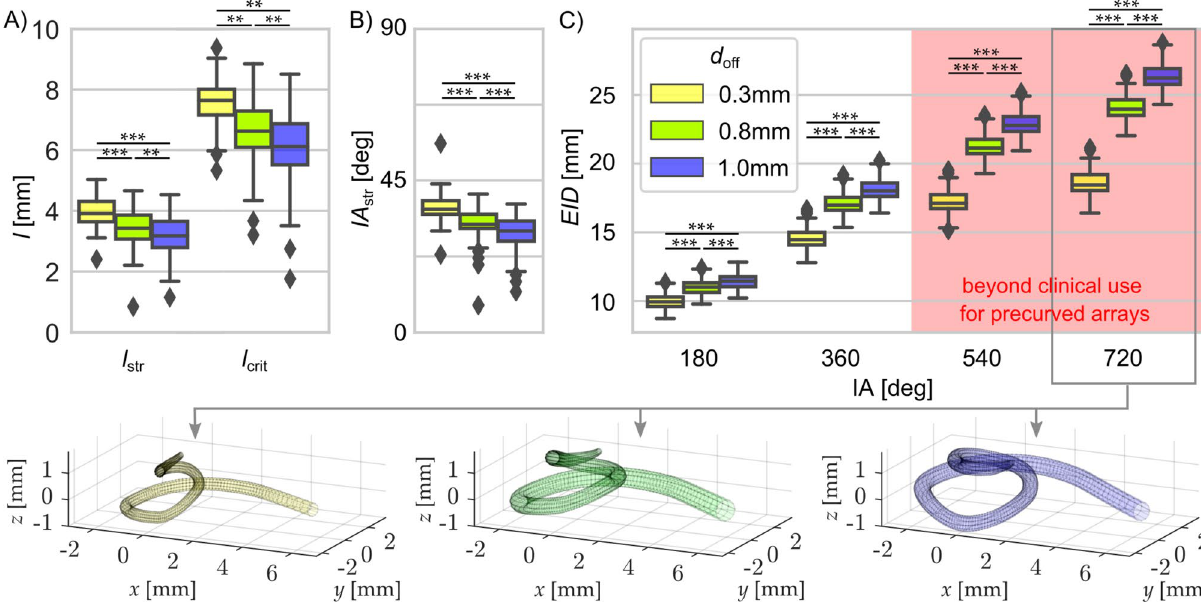
Figure 8. Approximated position of the cochlear implant array for three conventional perimodiolar electrodes with different distances d off to the modiolar wall. ( A ) The straight portion of the implant trajectory l str as well as the critical distance l crit at which the straight portion would touch the lateral wall are largest for the electrode that is closest to the modiolus (in yellow). ( B ) Also, the implantation angle covered by the straight portion of the implantation IA str is largest in the electrode that is closest to the modiolus. ( C ) Relation of insertion depth (EID, in mm) as a function of insertion angle (IA). Shown are theoretical values; perimodiolar or midscala arrays were not designed for the implantation of 540° or beyond. The electrode that is closest to the modiolus ( d off = 0.3mm) theoretically requires a shorter electrode array to reach the end of the second turn. The median trajectories for an insertion angle of 720° shown below suggest that close proximity to the modiolus (i.e. a small value of